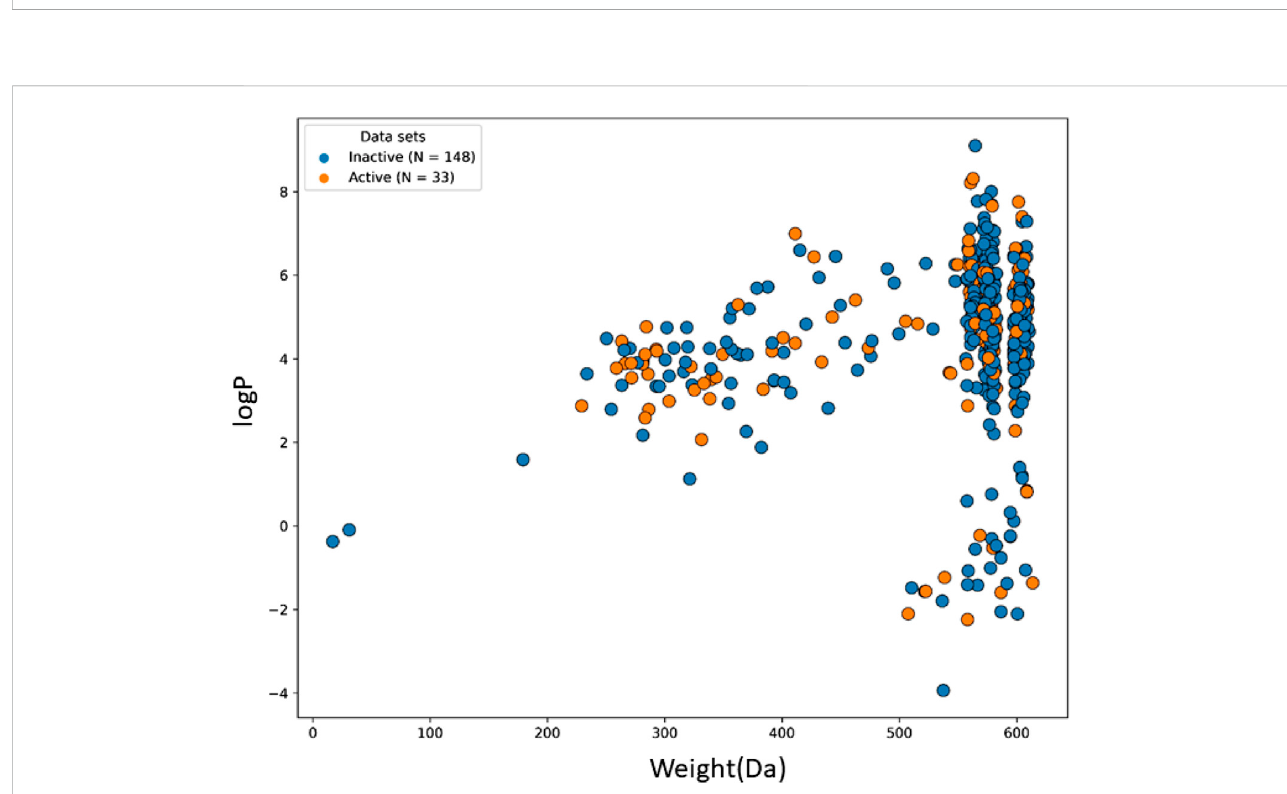
FIGURE 4 The chemical space and diversity distribution of the test set. The molecular weight and LogP de fi ne the chemical space.